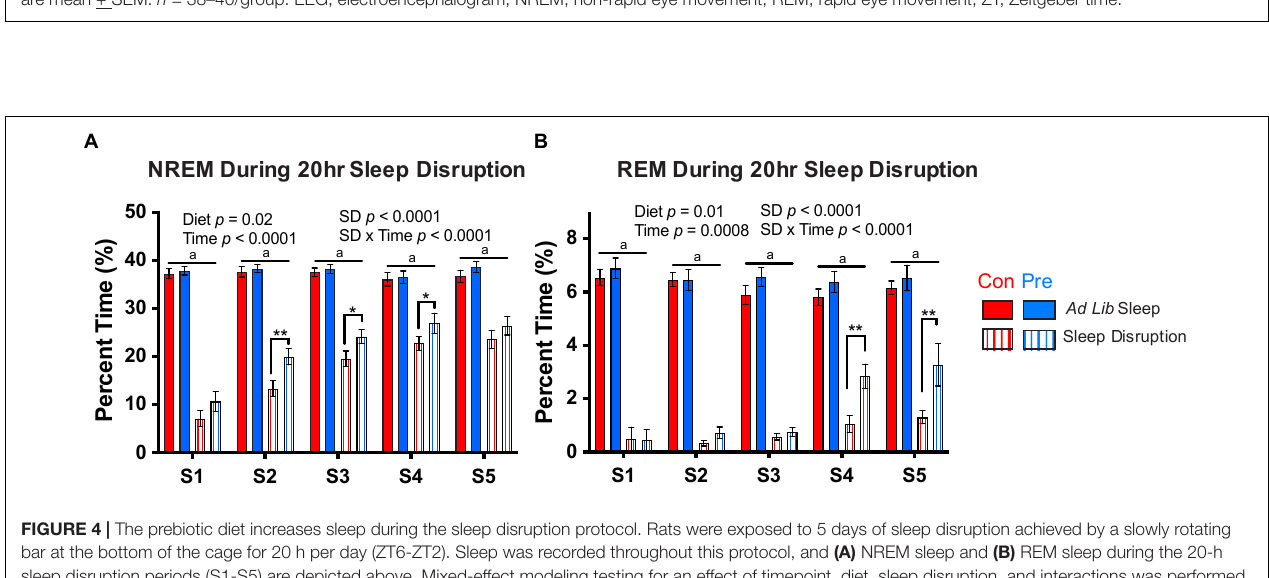
Frontiers in Neuroscience |